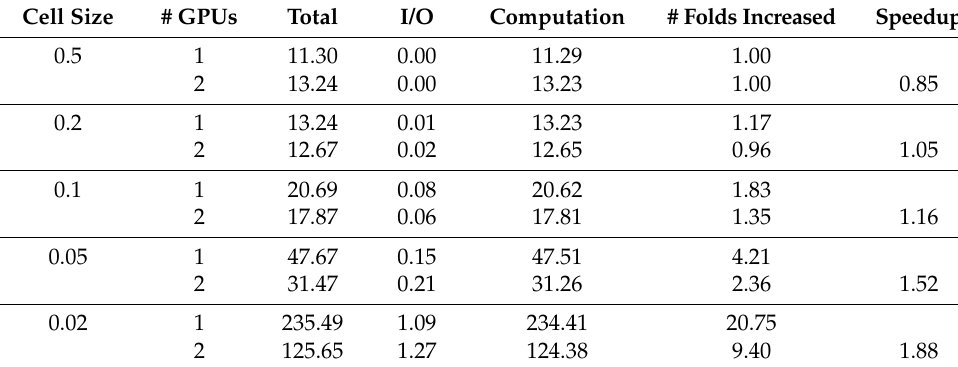
Table 3. Execution time (in seconds) for density estimation with ‘rule-of-thumb’ fixed bandwidth on synthetic datasets (n = 1,000,000 points; varied density raster cell size).